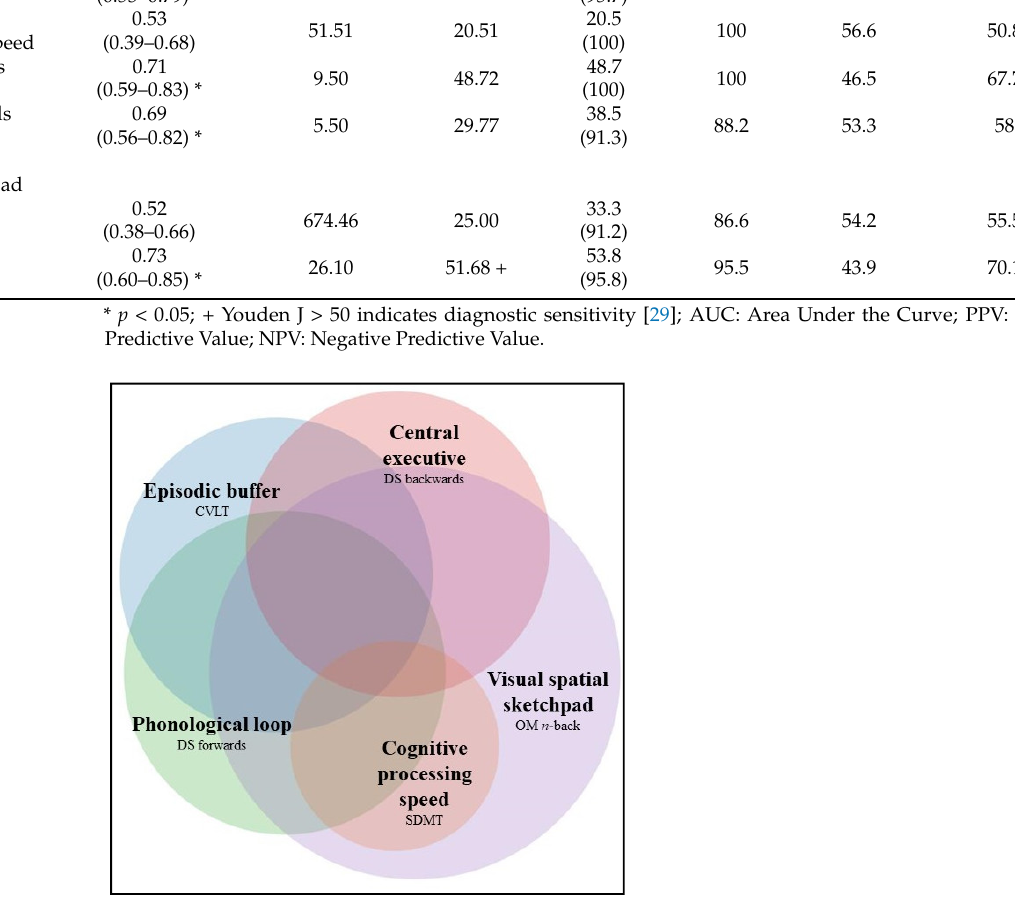
Figure 1. Proportion of early RRMS who failed each WM subcomponent test at baseline. Size of circles indicates the proportion of early RRMS patients who performed below cut-off scores in each WM test. The degree of overlap between tests (darker areas) represents the proportion of RRMS patients who failed multiple WM tests. Regions: OM n-back (70.5%), SDMT (18.2%), DS forward (43.2%), DS backwards (38.6%) and CVLT (40.9%). Overlap regions: OM n-back*SDMT (50%), OM n-back*DS forwards (29.5%), OM n-back*DS backwards (27.3%), OM n-back*CVLT (18.2%), DS forwards*SDMT (9.1%), DS backwards*SDMT (2.3%), DS forwards*CVLT (22.7%), DS backwards*CVLT (18.2%),